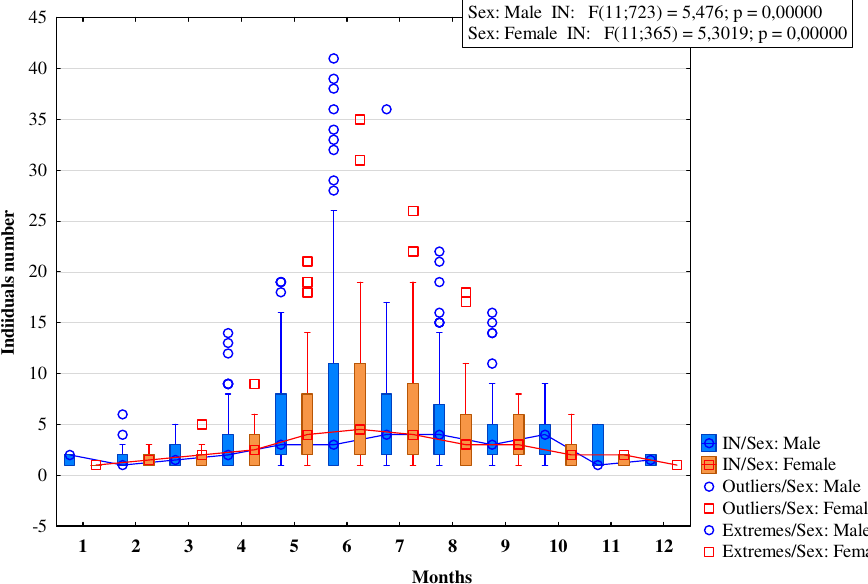
Figure 5. Individuals number of ectoparasites in black rats’ sexes depending on